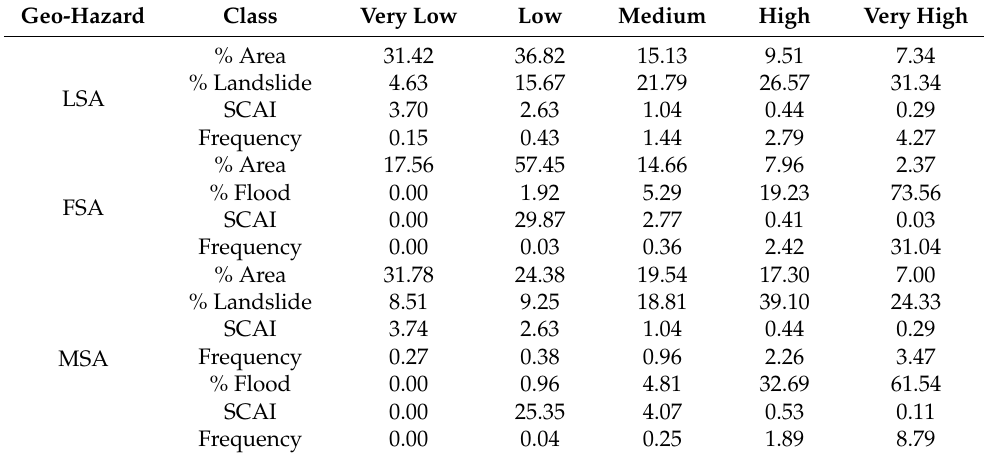
Table 17. Individual and multi-hazard susceptibility classes with the area coverage, hazard distribu- tion, SCAI, and frequency